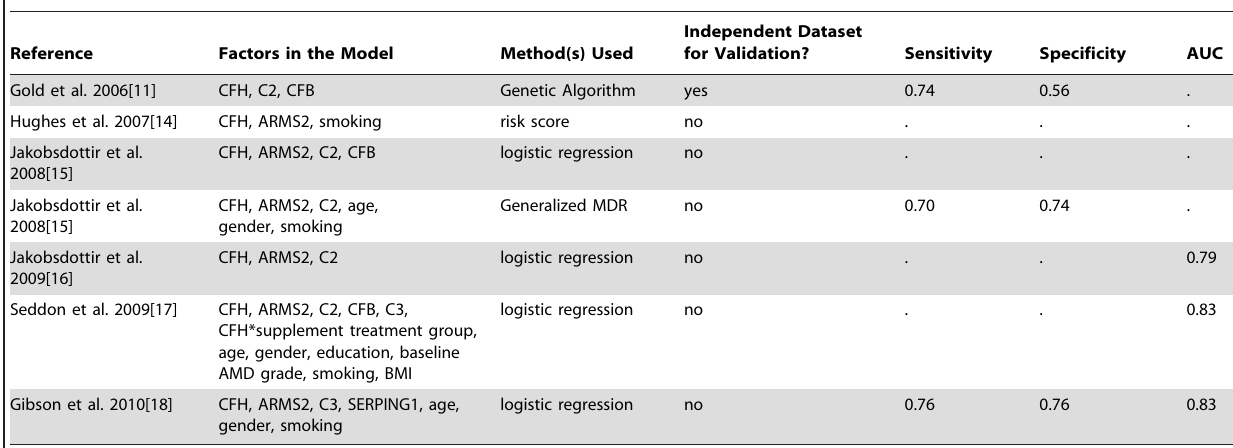
Table 1. Previous studies that developed an AMD